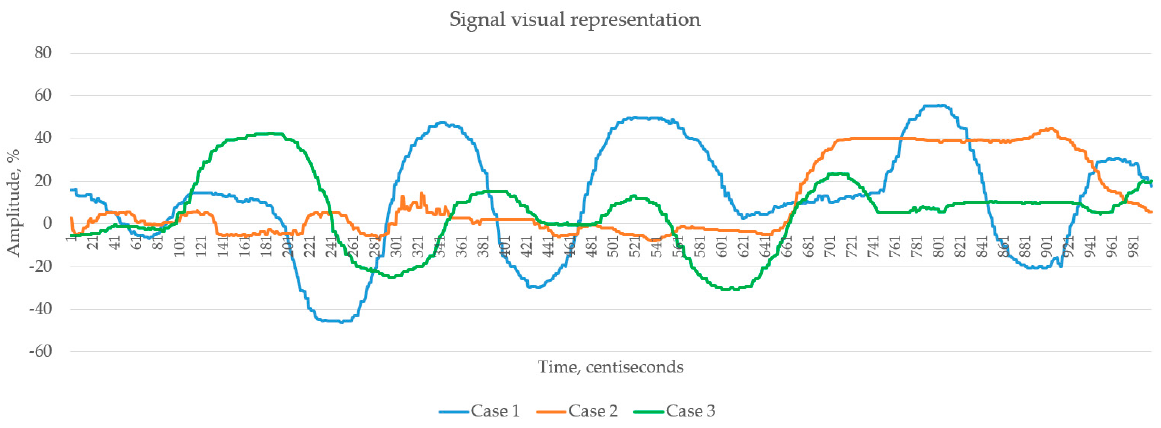
Figure 6. Visual representation of the data received.